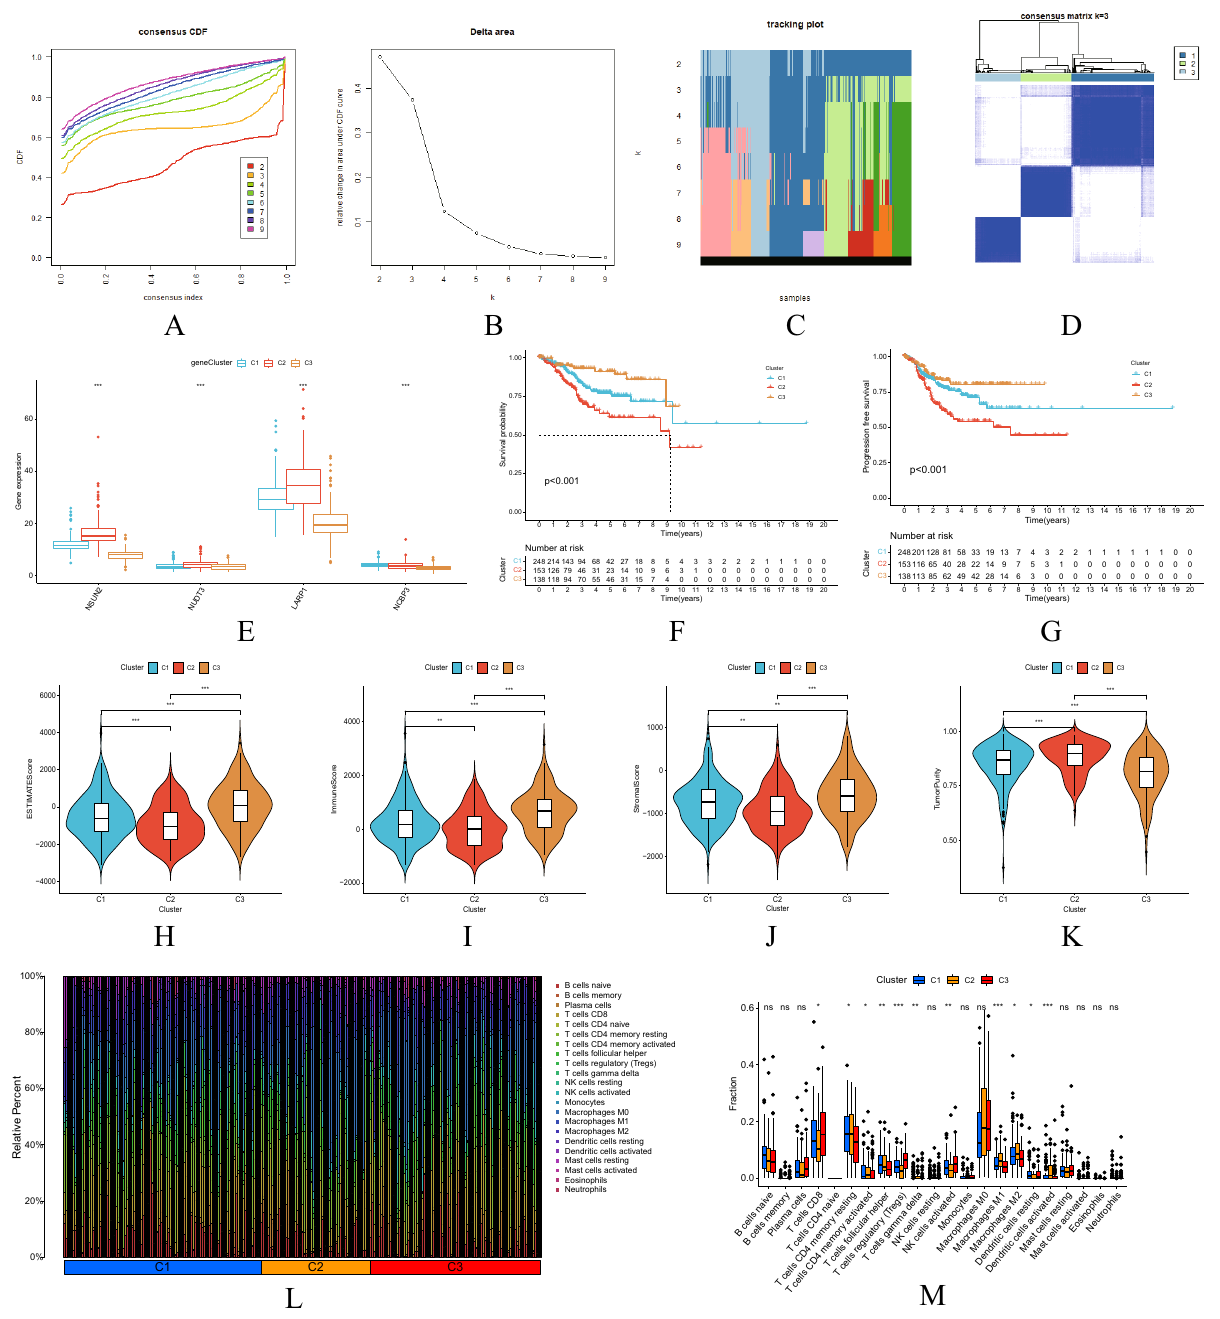
Figure 8. Survival, TME and immune cell infiltration analysis of consensus clustering recognition and typing. ( A ) Consensus clustering CDFs of k = 2–9. ( B ) Relative change in area under CDF curve of k = 2–9. ( C ) Tracking plot of k = 2–9. ( D ) Consensus clustering matrix of k = 3. ( E ) Differential distribution of 4 prognostic risk genes in 3 types among the three groups with respect to OS ( F ) and PFS ( G ) Kaplan–Meier survival curve. ( H ) ESTIMATEScore. ( I ) ImmuneScore; ( J ) StromalScore. ( K ) TumorPurity; Principal component analysis plot of immune cell infiltration matrix of 3 types ( L ) and variance analysis plot ( M